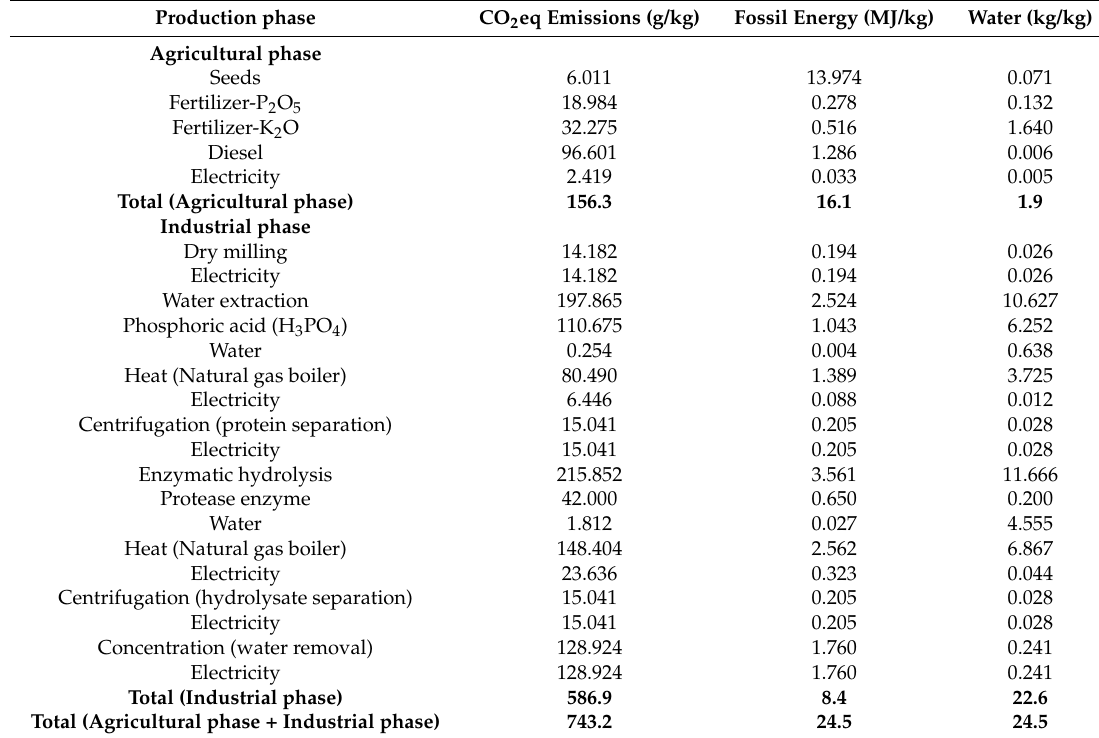
Table 5. LCA results for protein hydrolysate production from lupine grains (data refer to the production of 1 kg protein